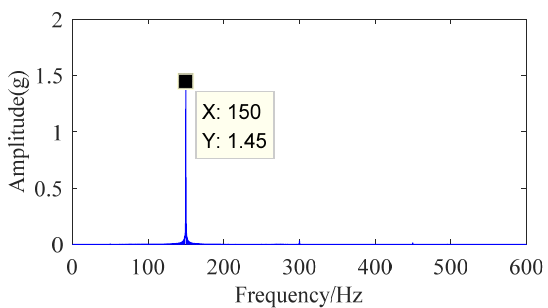
Figure 9. Vibration response of unpainted stainless steel clamp and pipeline under 150 Hz fixed- frequency excitation.